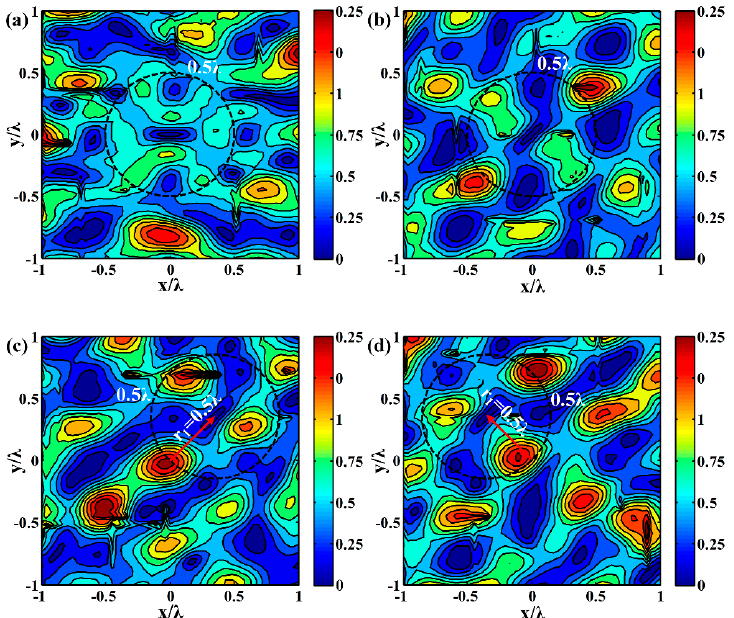
Figure 7. The measured pressure distribution within a λ × λ domain located at the center area of the pedestal. The elongated acoustic potential well is formed with orientation angle 0 ◦ in ( a ) and 45 ◦ in ( b ) and then shifted by 0.5 λ in the direction of 45 ◦ in ( c ) and 135 ◦ in ( d